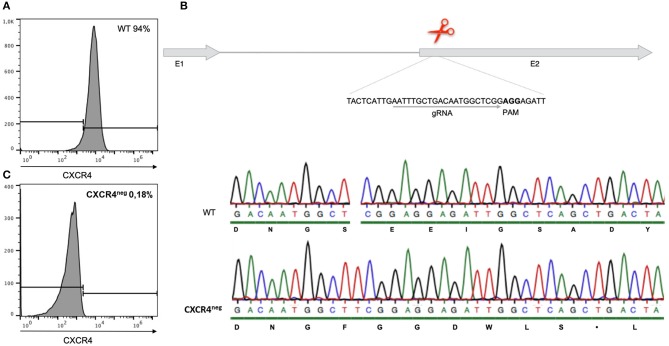
Gene editing of CXCR4 with the CRISPR/Cas9 system in chicken DT40 cells. (A) CXCR4 gene structure with guide RNA (gRNA) recognition site and protospacer-adjacent motif (PAM) sequence. (B) Sequence analysis of CXCR4neg and wt DT40 cells with amino acid sequence. CXCR4neg cell sequence analysis revealed a T insertion causing a frameshift and therefore generation of a premature stop codon. (C) Flow cytometry analysis of CXCR4neg and wt cells with staining for CXCR4. Gene editing successfully knocked out the CXCR4 chemokine receptor.